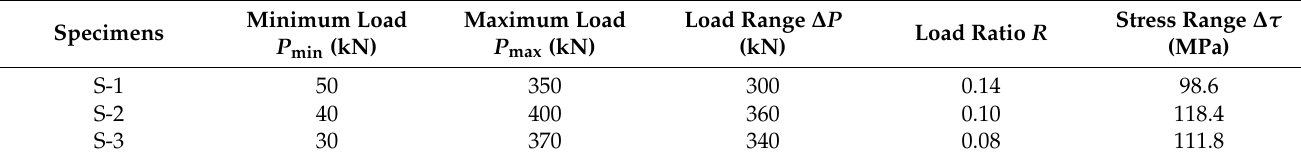
Table 2. Fatigue loading details for push-out